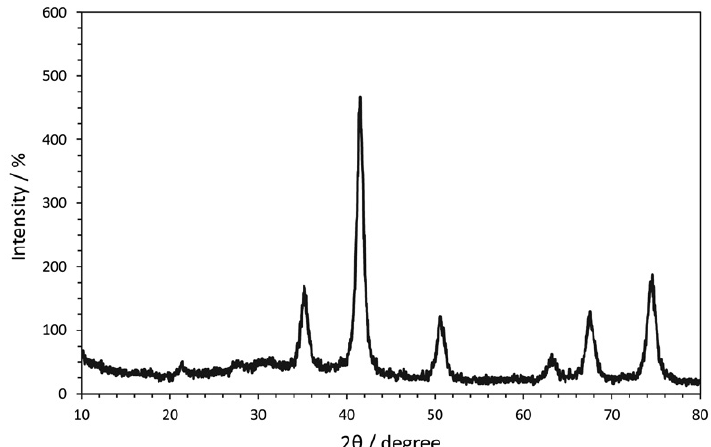
Figure 3. XRD pattern of Fe 3 O 4 @ PyHBr 3 MNP.